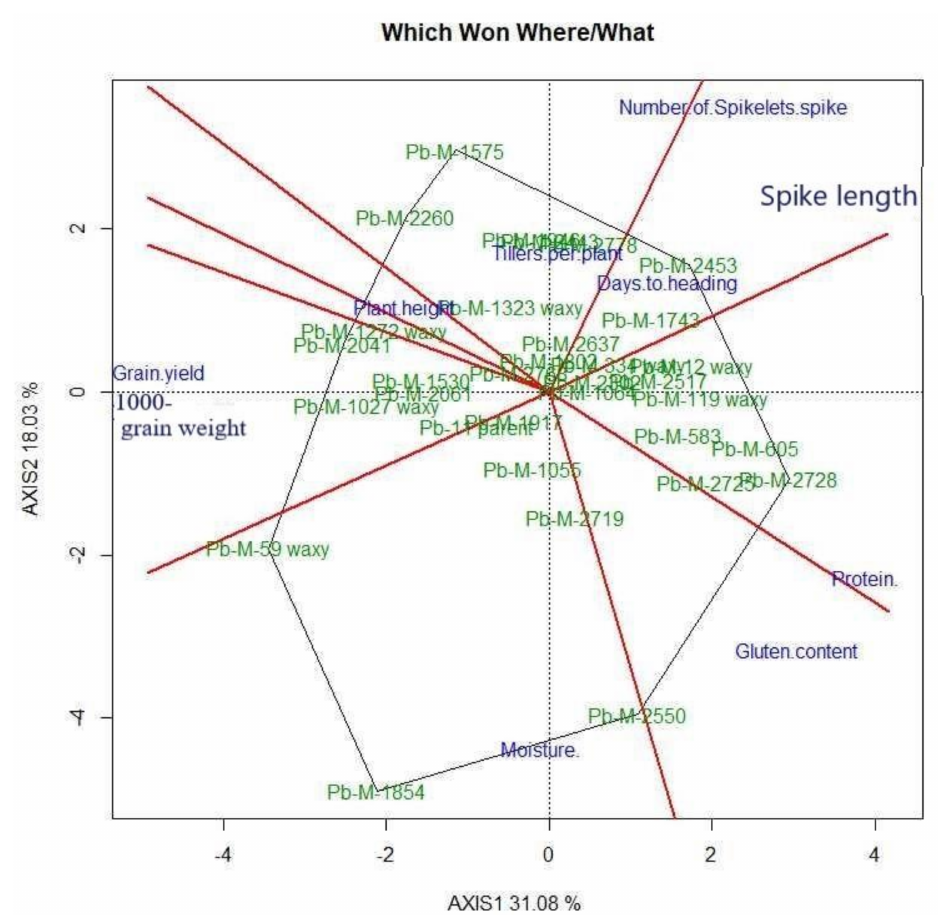
Figure 8. Polygon view of the GT bi-plot of 32 mutant lines and the wild type sown at the NIAB location. Regarding the polygon plot of the NIBGE location, the vertex mutant lines were Pb-M-59 waxy, Pb-M-12 waxy, Pb-M-1027 waxy, Pb-M-1575, and Pb-M-1272 waxy (Fig- ure ?? ). The grain yield and 1000-grain weight traits fell in the Pb-M-1027 waxy sector, suggesting that Pb-M-1027 waxy had the highest or nearly the highest values for these traits. Likewise, Pb-M-1272 waxy showed the highest values in terms of plant height, tillers per plant, and moisture content. Pb-M-1575 showed high values in terms of protein content